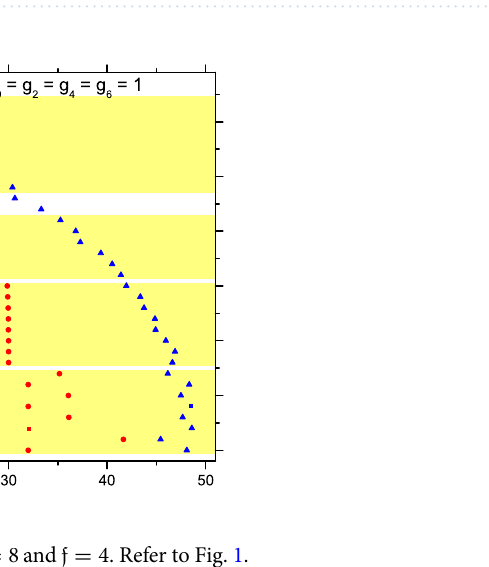
Table 5. The overlaps � ( [ 5 ][ 3 ] ) S | � S ,1 � (denoted as 5 − 3 ) and � ( [ 4 ][ 4 ] ) S | � S ,1 � ( 4 − 4 ), where { (cid:31) S ,1 } are the eigen-b-states of the associated Hamiltonians with N = 8 and f = 3 , and they are lying in Zone III and IV. Refer to Table 2.